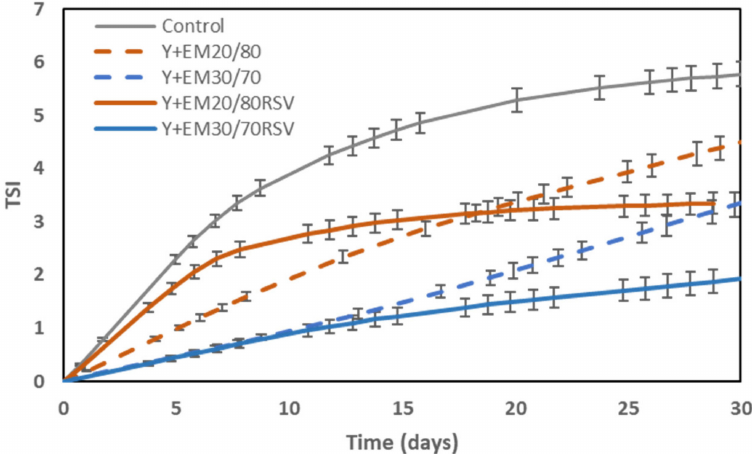
Figure 3. Evolution of the Turbiscan Stability Index (TSI) of the different types of yoghurts over time to study how the addition of emulsion to yoghurt affects